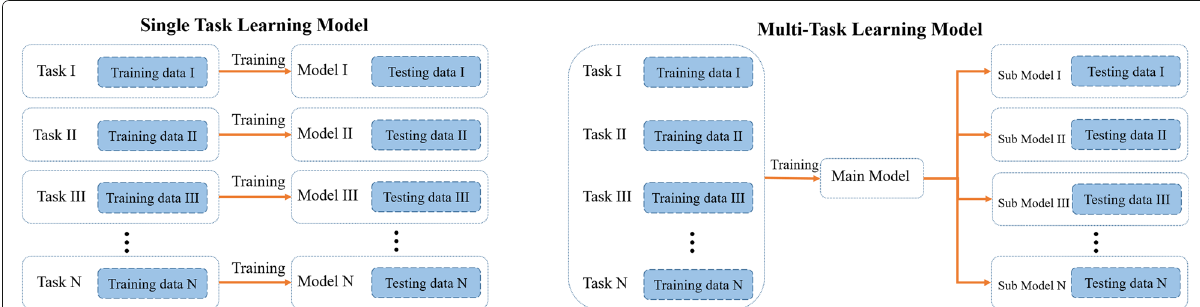
Fig. 1 The framework of Single-Task model and Multi-Task model. The Single-Task model: Each task has its independent goal of the model. Its own trained model may be impacted by insufficient or limited training data. The Multi-Task model: Integrating tasks in different domains to one framework, the paralleled model learns a reliable feature via solve tasks with a similar logic simultaneously